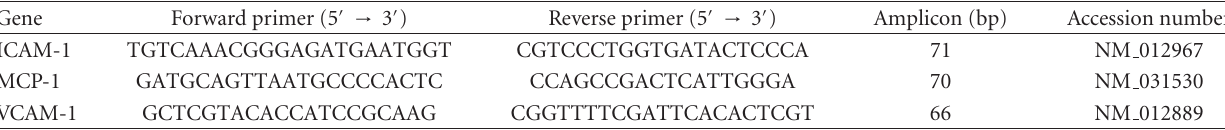
Table 1: Sequences of primas for